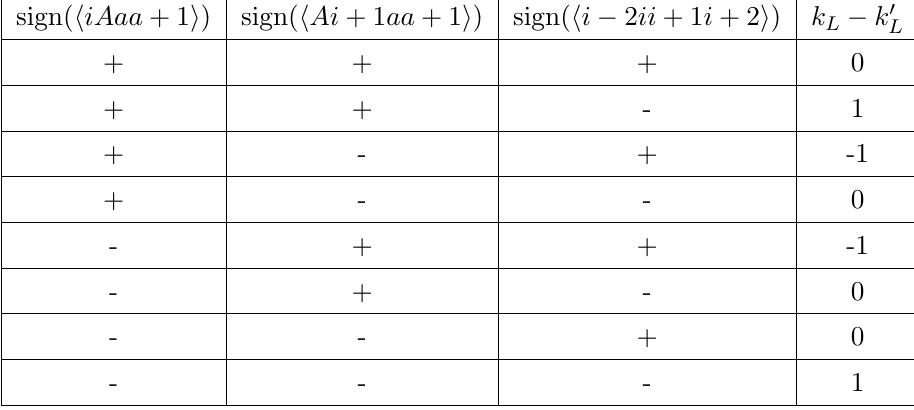
Table 3 . Relation between k L and k 0